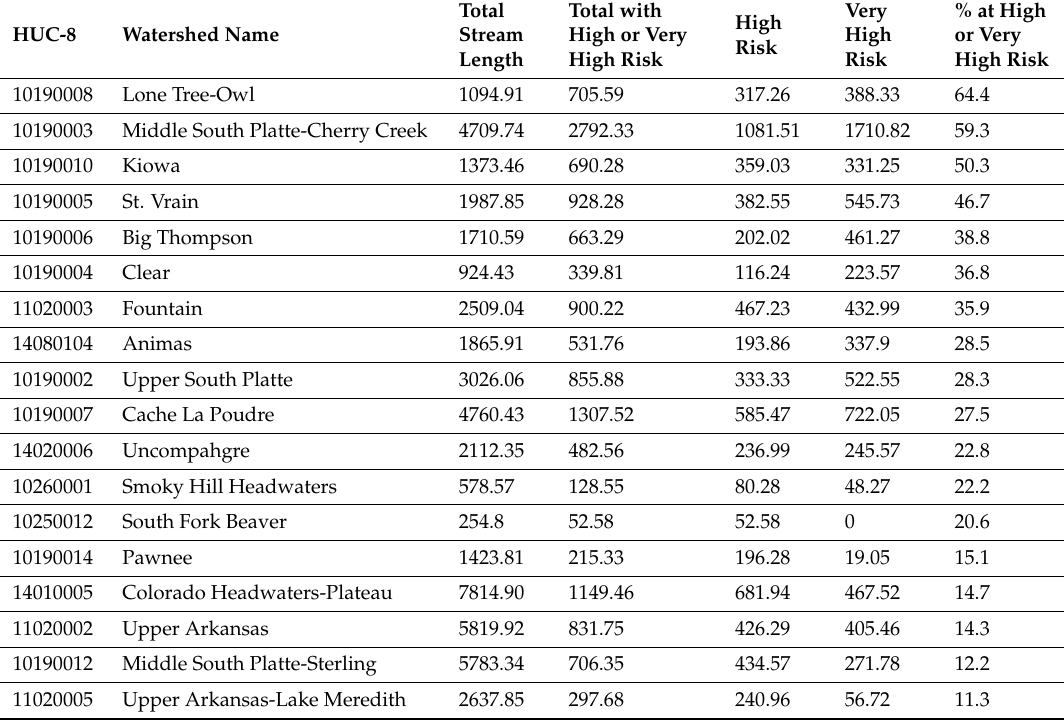
Figure 8. Risk/demand assessment for stream mitigation in Colorado by HUC-8 watershed. Table 9. Colorado HUC-8 watersheds that are most likely to experience stream impacts in the near term (measurements in 000s of LF).